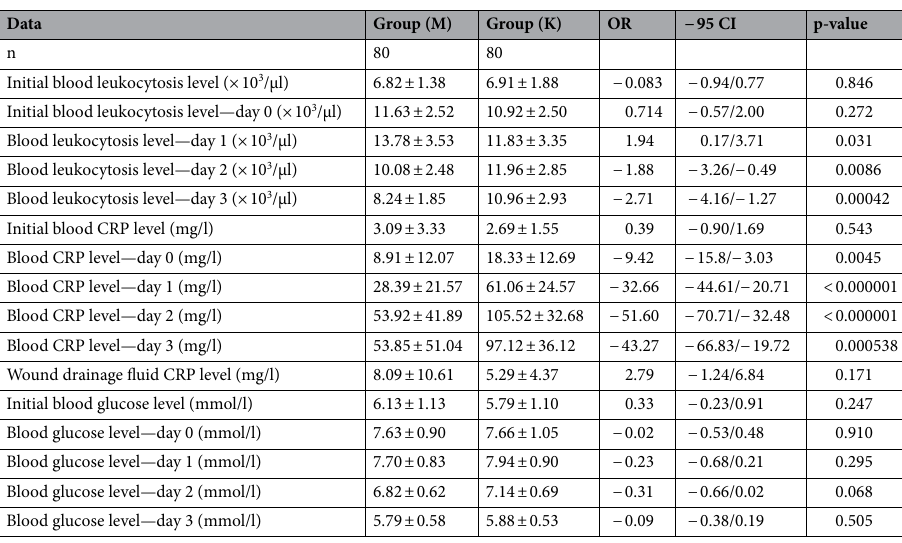
Table 3. Leukocytosis CRP and glucose levels in the analyzed patients aged above 65 years old divided into the study (M) and control (K) groups. CRP C reactive protein, OR odds ratio, CI confidence interval.